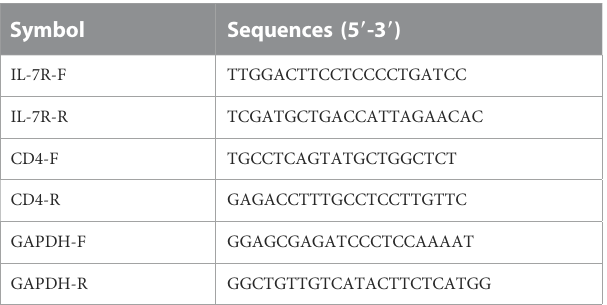
TABLE 1 The primer sequences in PCR